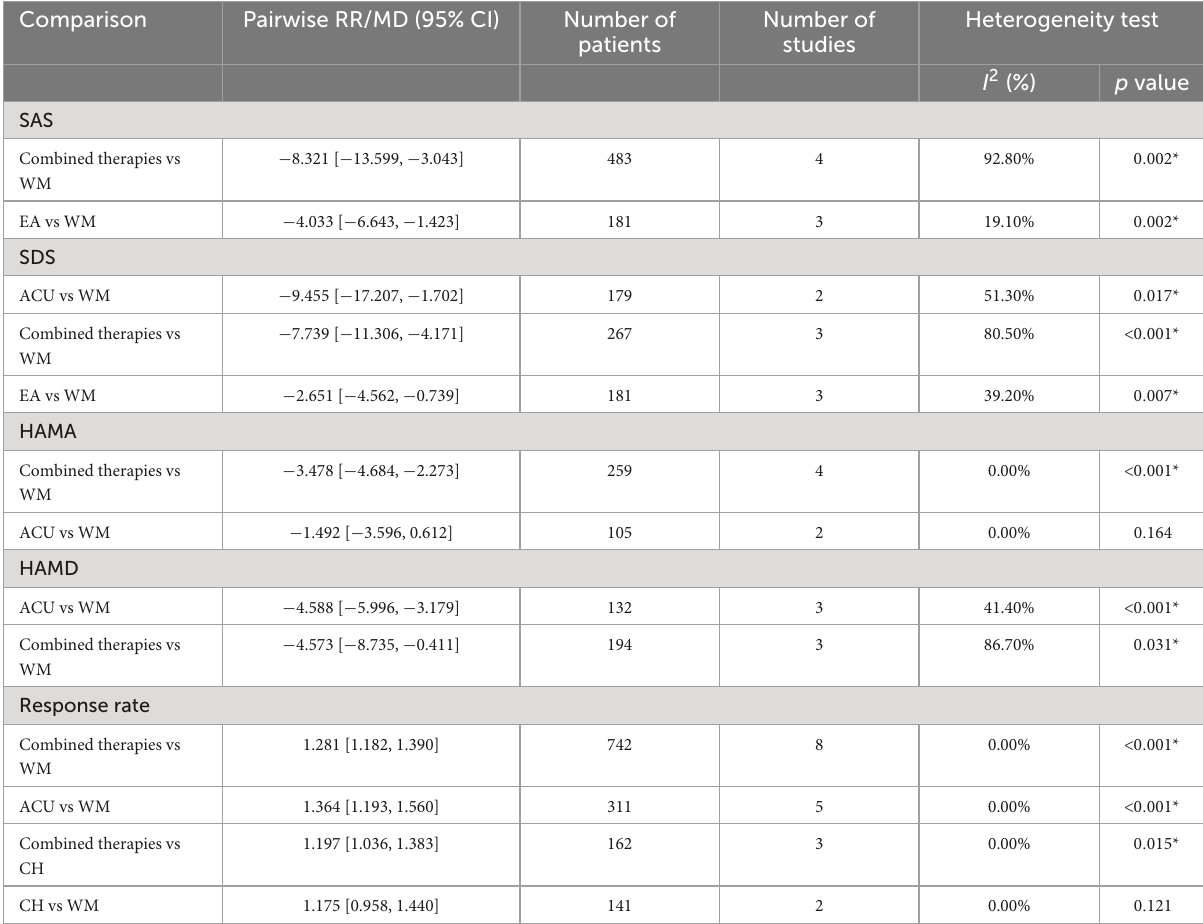
TABLE 3 Pairwise meta-analyses.